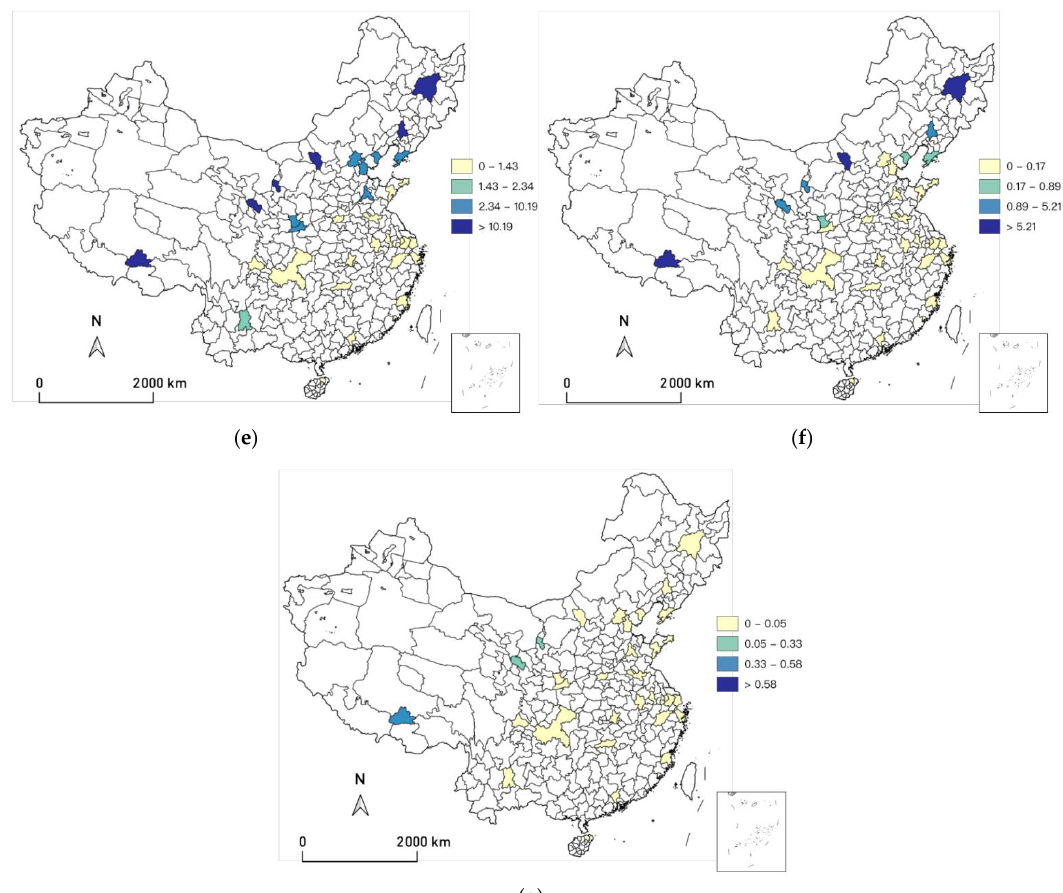
Figure 4. The geographical distribution of the number of days with daily average temperature in the previous three months in seven 5 °C temperature bins. ( a ) Number of days in the previous 90 – day period with daily average temperature over 30 celcius degrees; ( b ) Number of days in the previous 90 – day period with daily average temperature between 25 and 30 celcius degrees; ( c ) Number of days in the previous 90 – day period with daily average temperature between 20 and 25 celcius degrees; ( d ) Number of days in the previous 90 – day period with daily average temperature between 15 and 20 celcius degrees; ( e ) Number of days in the previous 90 – day period with daily average temperature between 10 and 15 celcius degrees; ( f ) Number of days in the previous 90 – day period with daily average temperature between 5 and 10 celcius degrees ; ( g ) Number of days in the previous 90 – day period with daily average temperature below 5 celcius degrees.